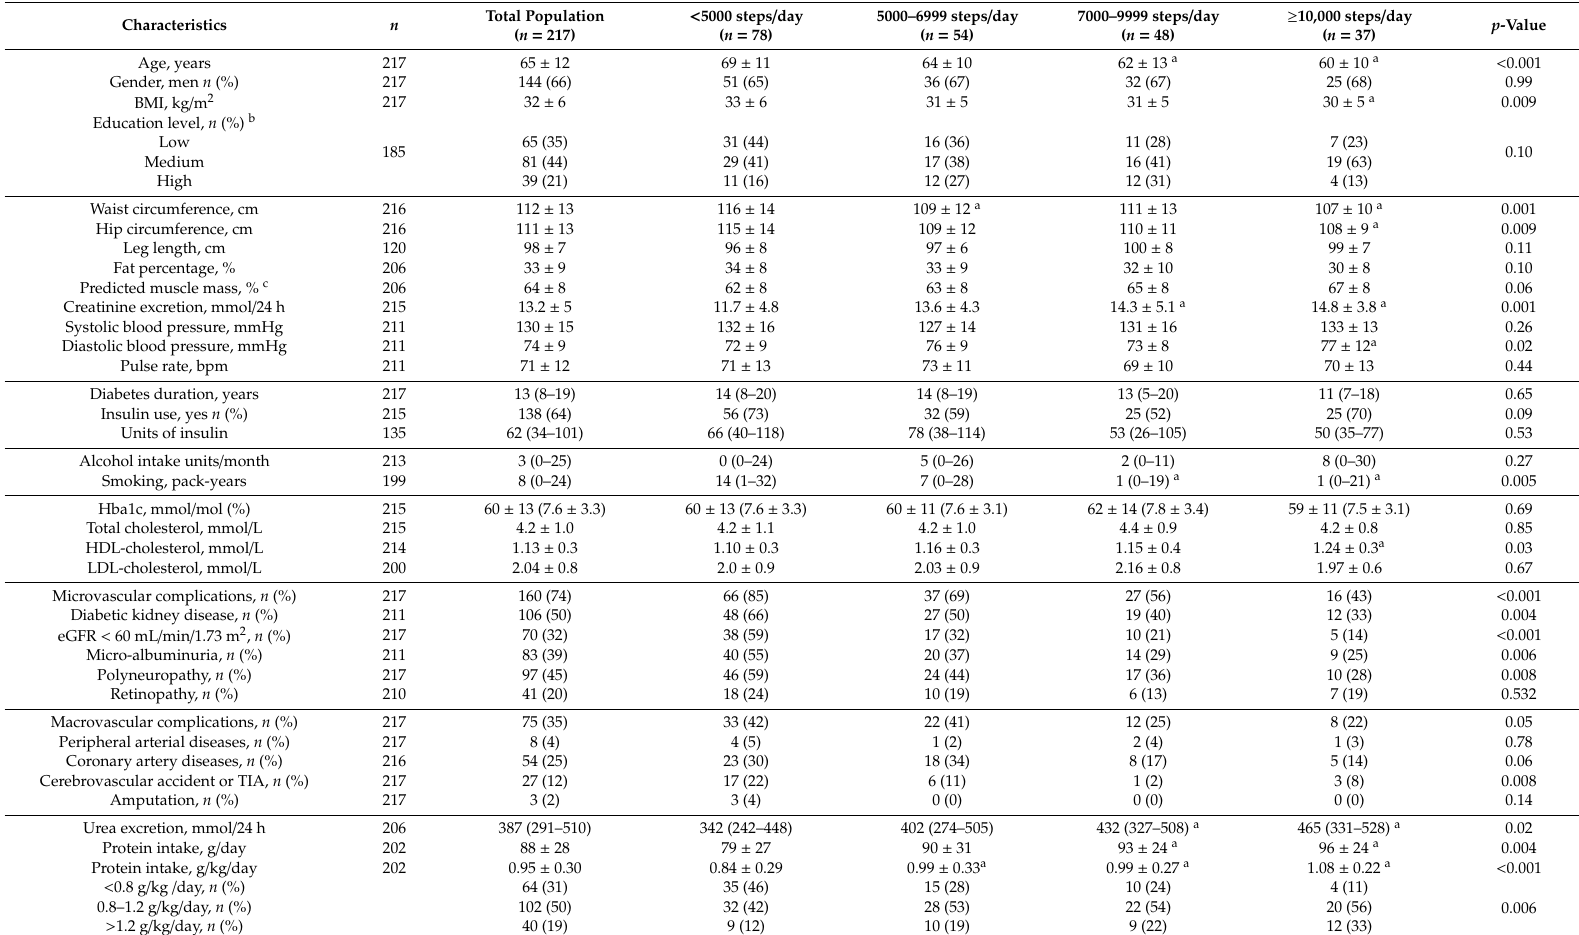
Table 1. Patient characteristics stratified by total steps per